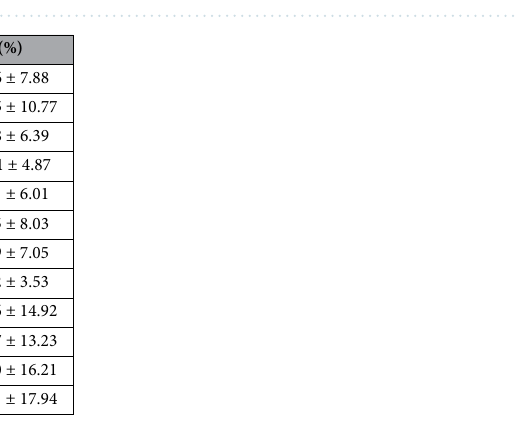
Figure 8. Mean accuracy (%) for all the DA methods and for the case of no artificial data added (NONE). In all the experiments (except NONE), 100 artificial samples per group were generated with the same 50% of the real data. The light blue bars correspond to the methods that worsened the average accuracy compared to the NONE method.